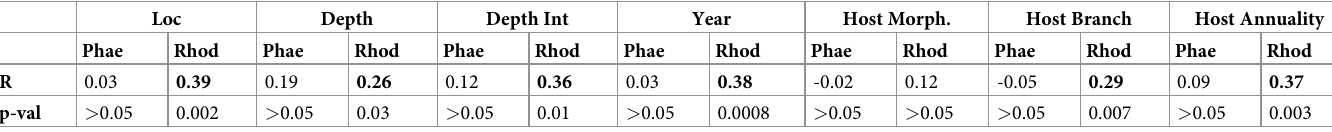
cluster = average linkage, bootstrap = 94%, not shown). A redundancy analysis (RDA), on the other hand, showed a separation between DI and LI communities (Fig 5). This was corrobo- rated by the results of the Mantel test (geographical distance matrix vs. diatom communities, Table 3. ANOSIM test results performed on communities from Phaeophyceae (Phae) and Rhodophyta (Rhod) hosts. Loc Depth Depth Int Year Host Morph. Host Branch Host Annuality Phae Rhod Phae Rhod Phae Rhod p-val > 0.05 0.002 > 0.05 0.03 > 0.05 0.01 0.0008 Loc = Location, Depth Int = Depth Interval, Host Morph = Host Morphology, Host Branch = Host Branching pattern, Host Annual = Host Annuality. Significant values are highlighted in